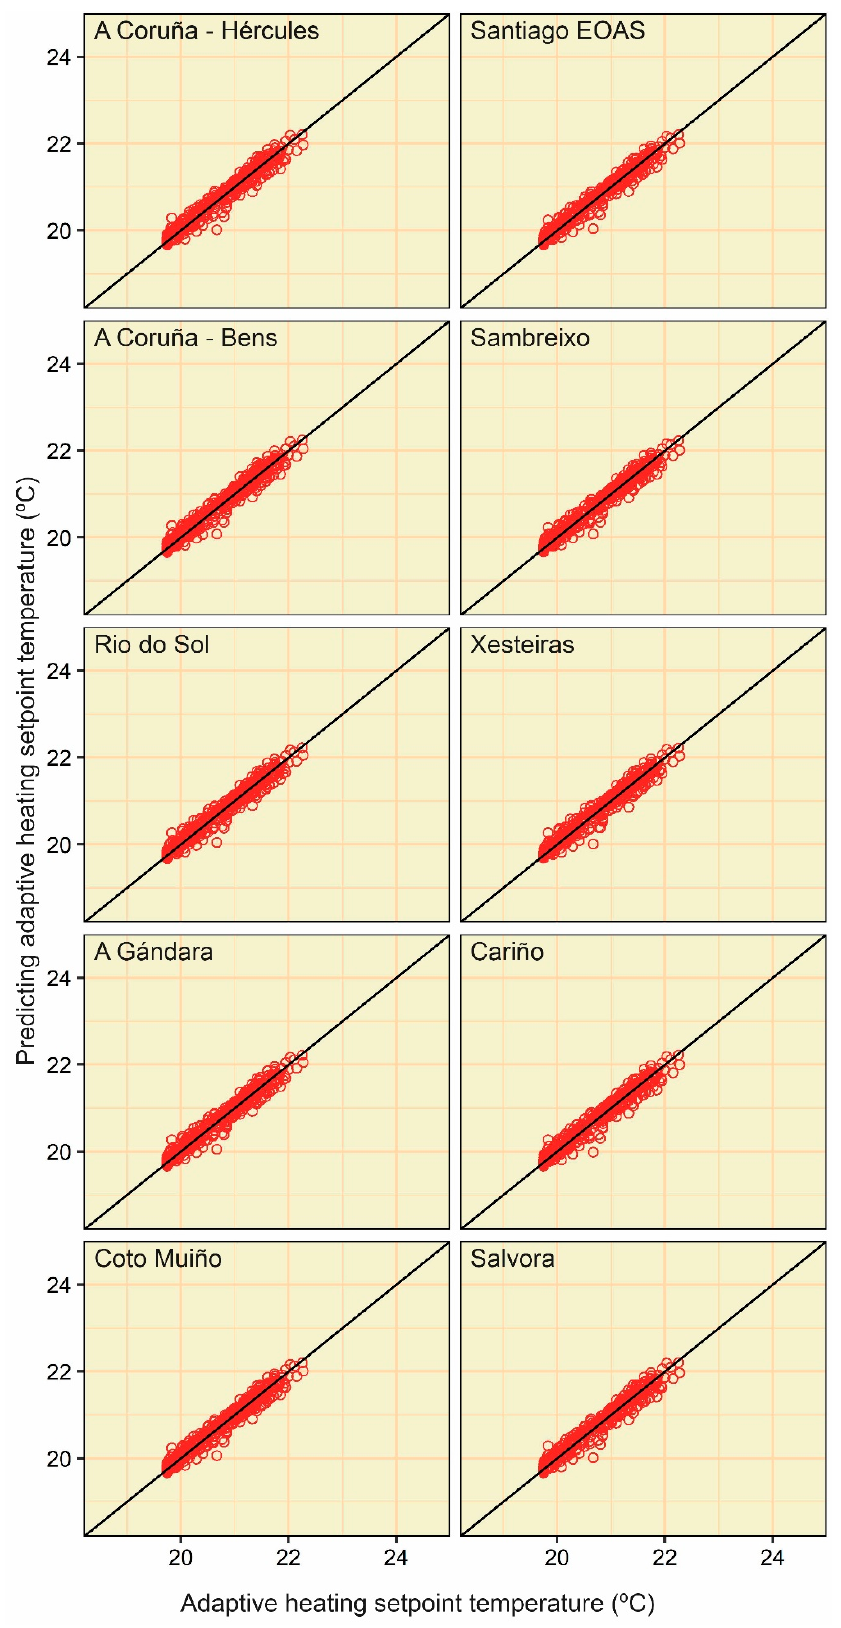
Figure A15. Point clouds between the actual and predicting adaptive heating setpoint temperature values (category III) of the MLR (approach 1).